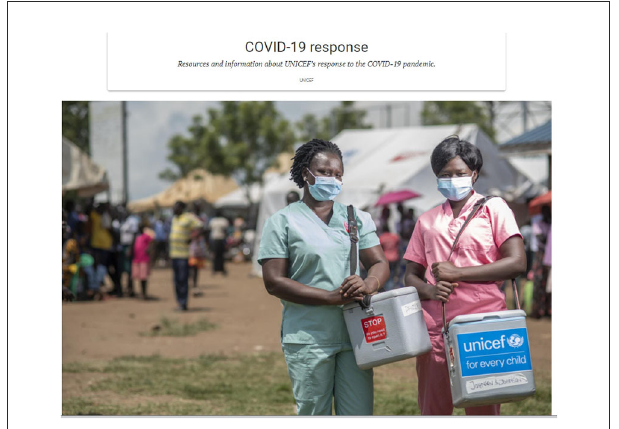
FIGURE3 Save the Children’s website calling for funding against COVID-19. https://www.savethechildren.it/save-the-future.